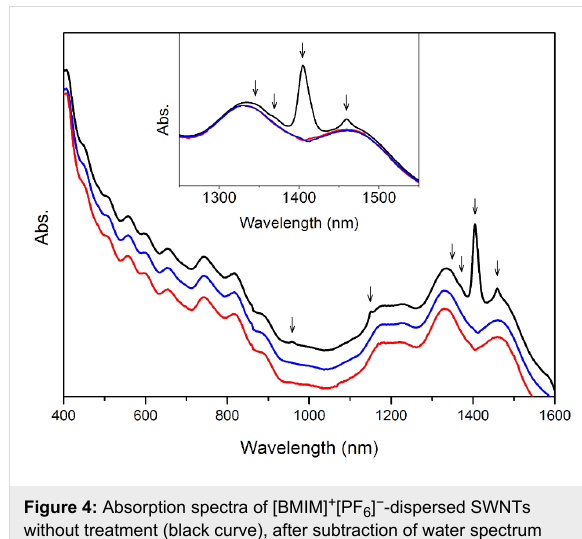
Figure 4: Absorption spectra of [BMIM] + [PF 6 ] − -dispersed SWNTs without treatment (black curve), after subtraction of water spectrum (blue curve), and treated under vacuum for 10 hours (red curve). The spectra are offset arbitrarily in the vertical direction for clarity. The inset shows the partially enlarged spectra. Arrows indicate the positions of water